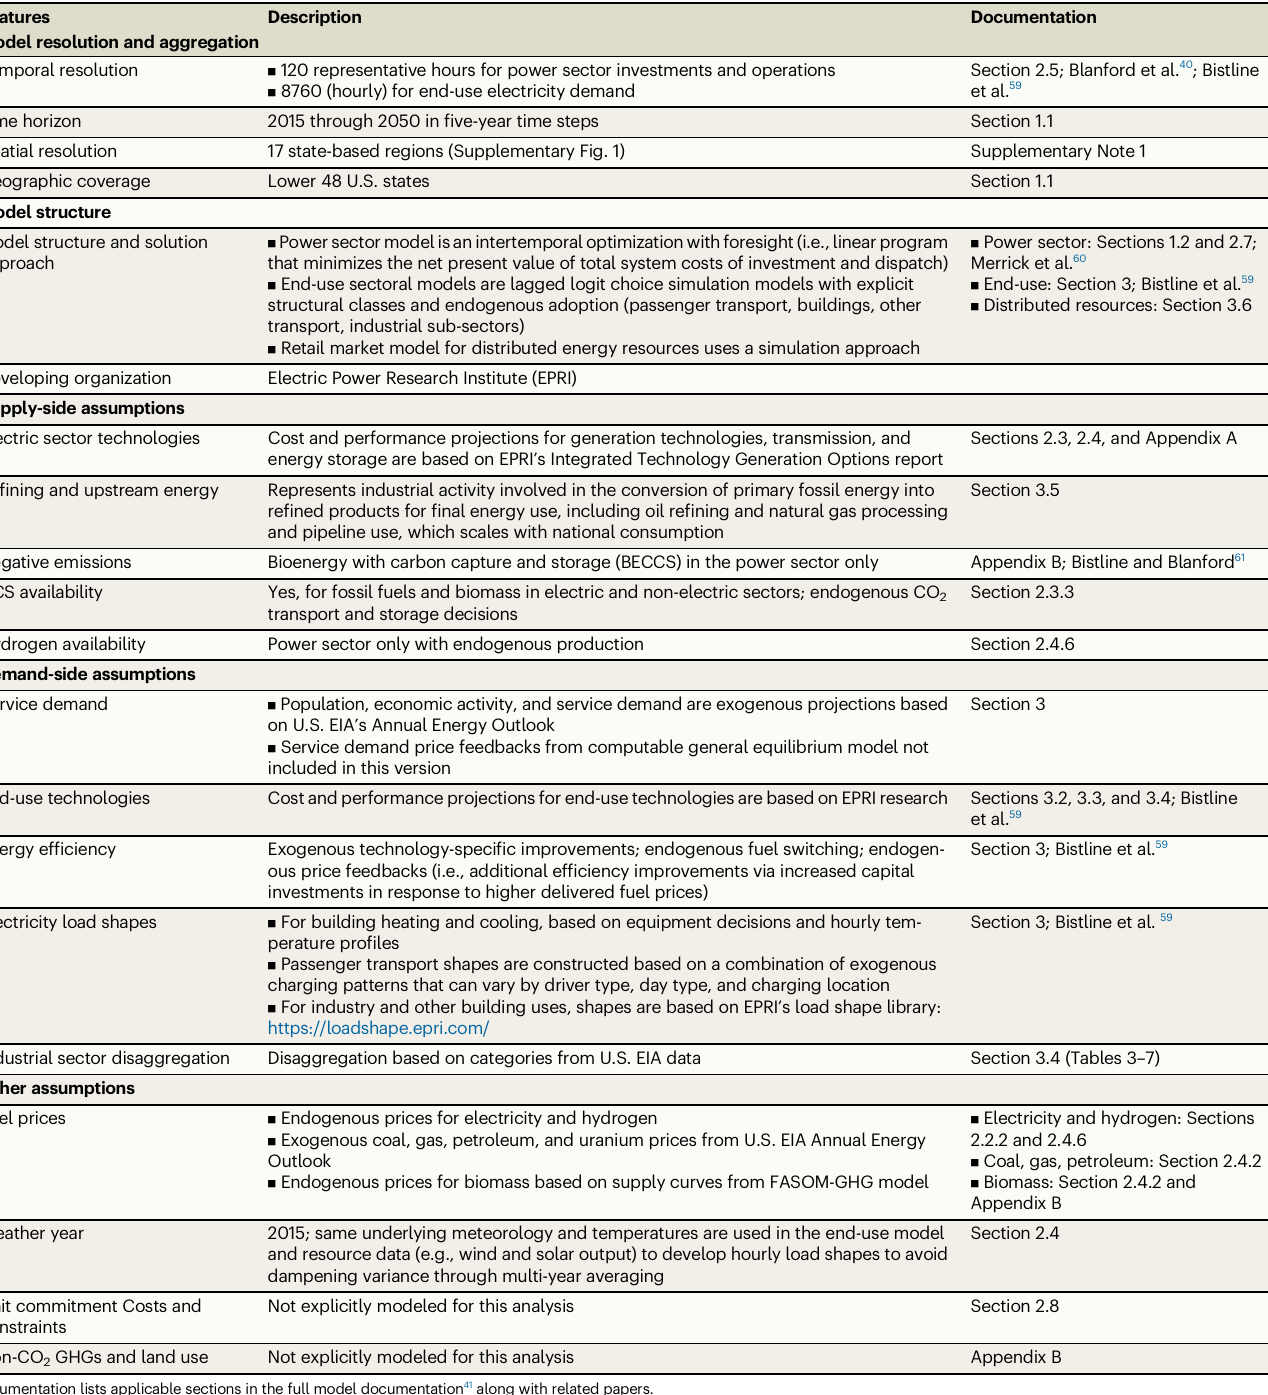
Table 1 | Summary of key features and assumptions of